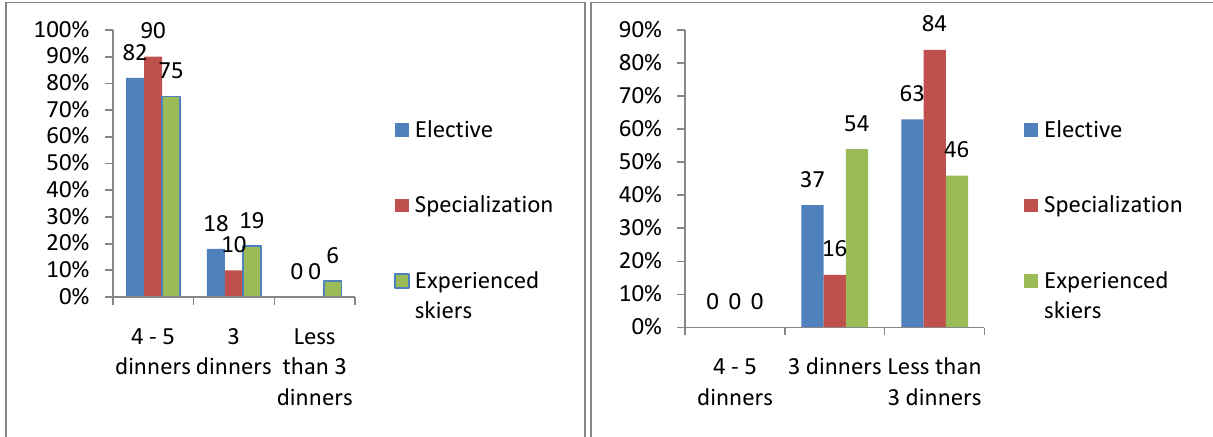
Figure 1. Daily frequency of dinners Figure 2. Daily intake of cereals – baked